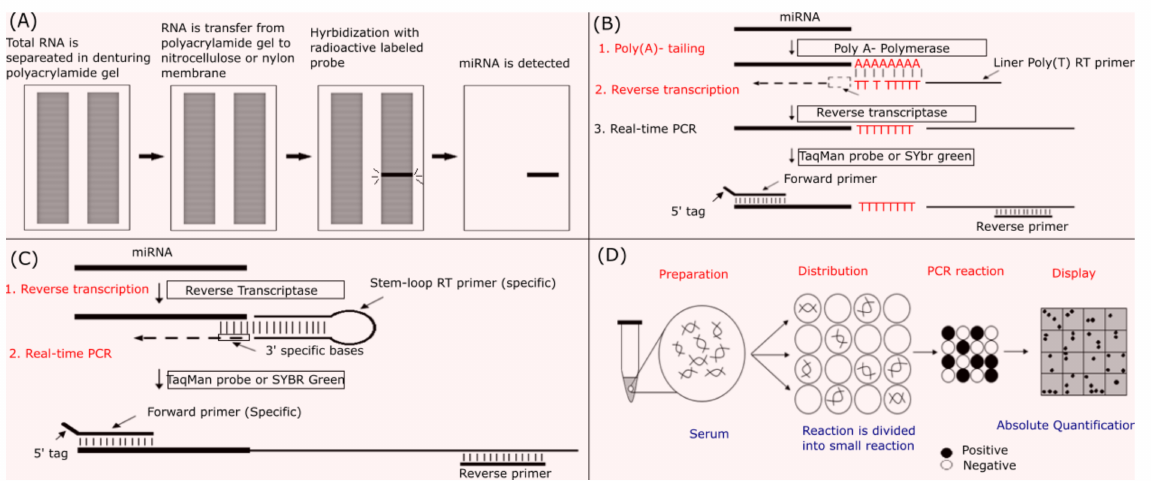
Figure 4. Biological molecular methods for microRNA detection and quantification. ( A ) Northern blot; ( B ) poly ( A ) real-time reverse transcriptase PCR; ( C ) stem–loop real-time reverse transcriptase PCR; ( D ) digital